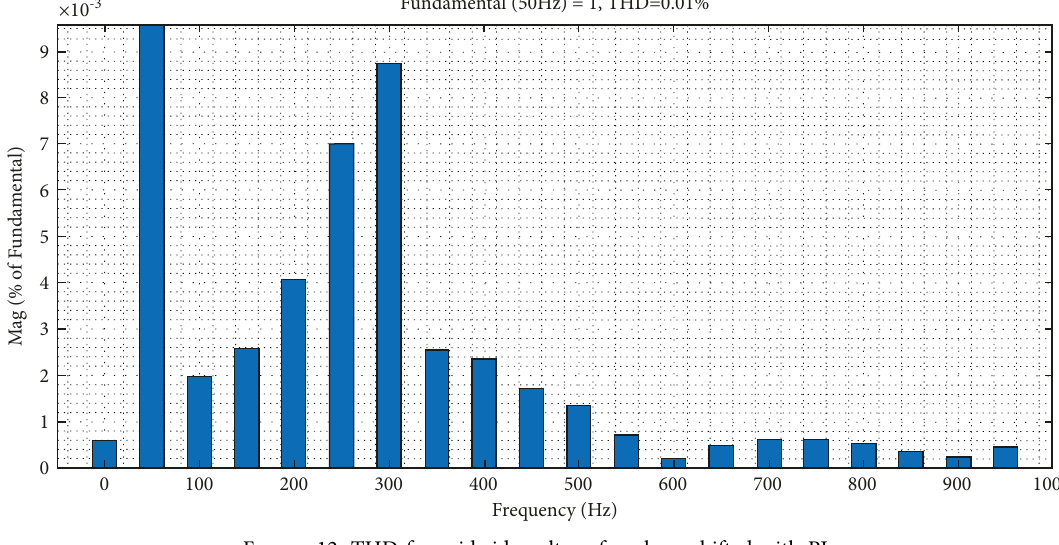
Figure 12: THD for grid side voltage for phase-shifted with